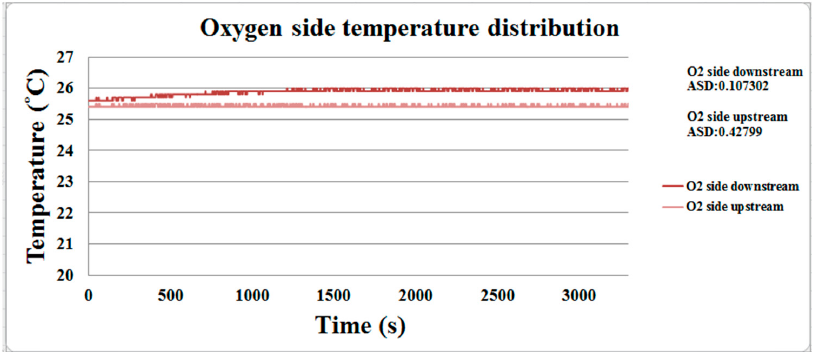
Figure 14. The oxygen side’s temperature distribution during the proton battery discharge.